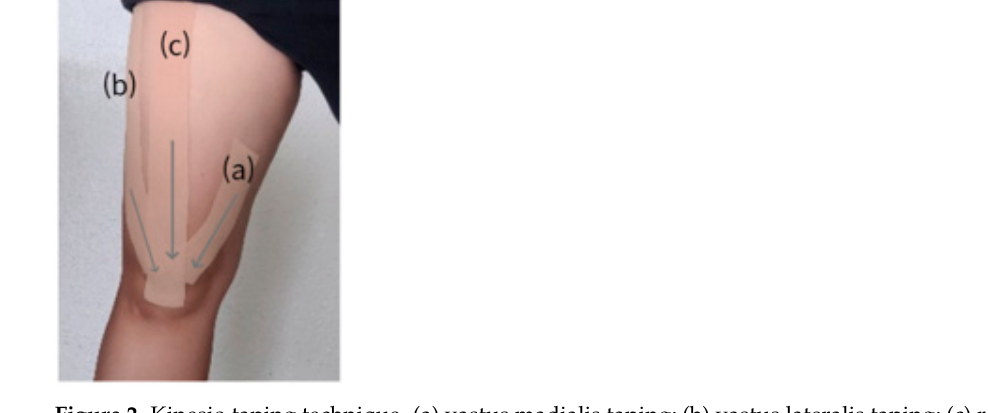
Figure 2. Kinesio taping technique. (a) vastus madialis taping; (b) vastus lateralis taping; (c) rectus femoris taping.